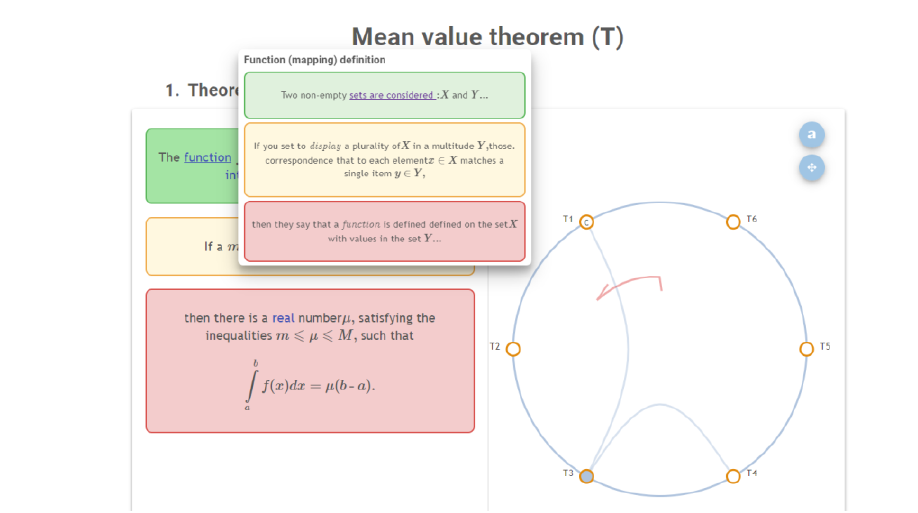
Fig. 3. Links in the DLS "NOMOTEX".